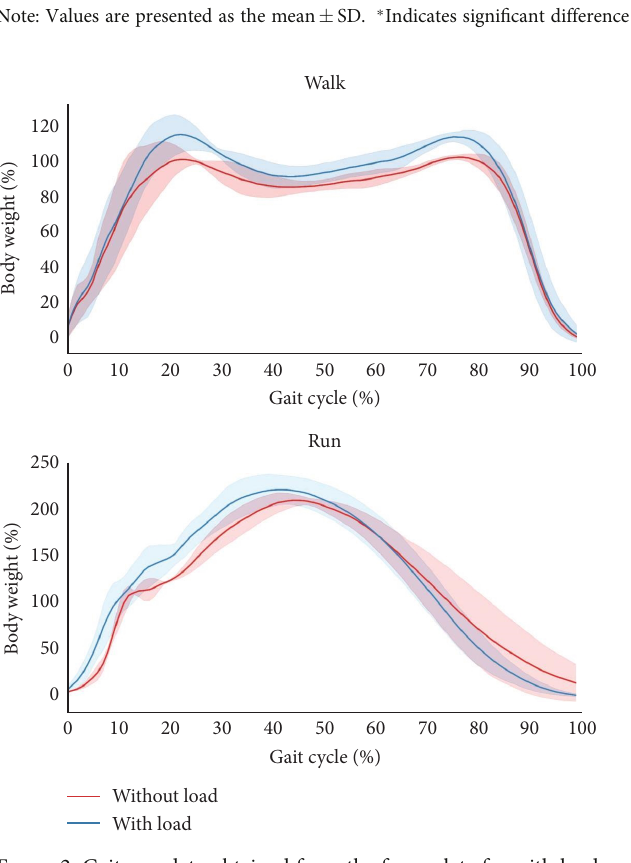
F IGURE 2: Gait raw data obtained from the force plate for with load carriage and without load carriage. The x -axis shows the normalized gait cycle